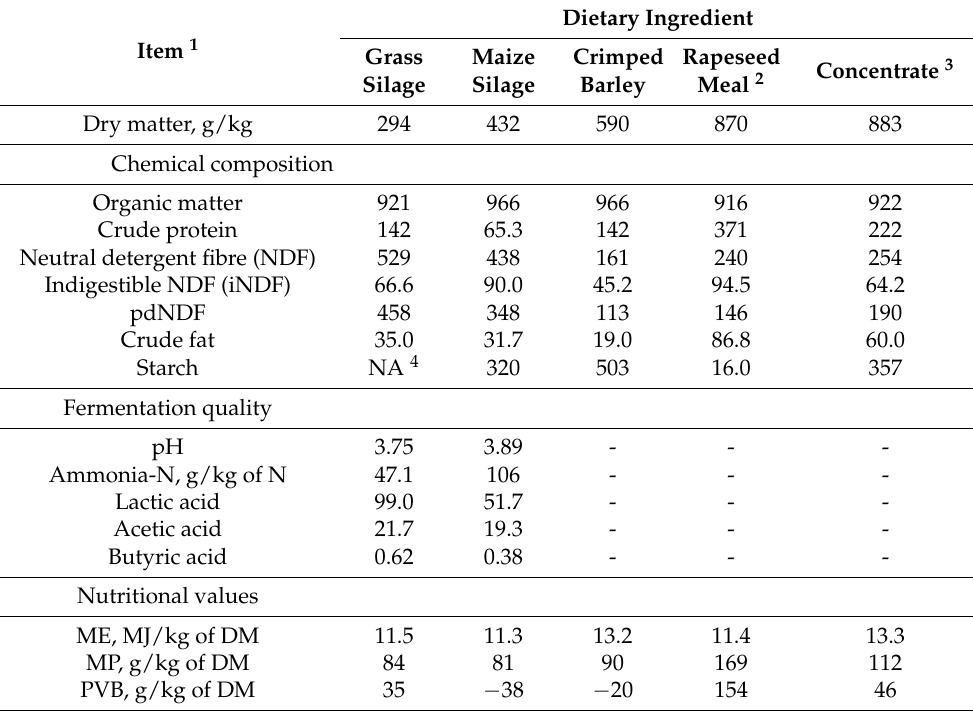
Table 1. Chemical composition and nutritional values of the dietary ingredients used in experimental diets fed to dairy cows (g/kg of DM unless otherwise stated). Dietary Ingredient Item 1 Grass Maize Crimped Rapeseed Concentrate 3 Silage Silage Barley Meal 2 Dry matter, g/kg 294 432 590 870 Chemical